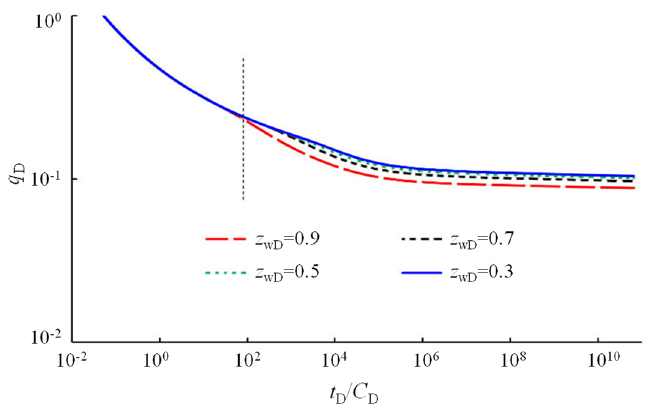
Figure 6. Relationship between the distance of a horizontal well from the oil–water contact and productivity.